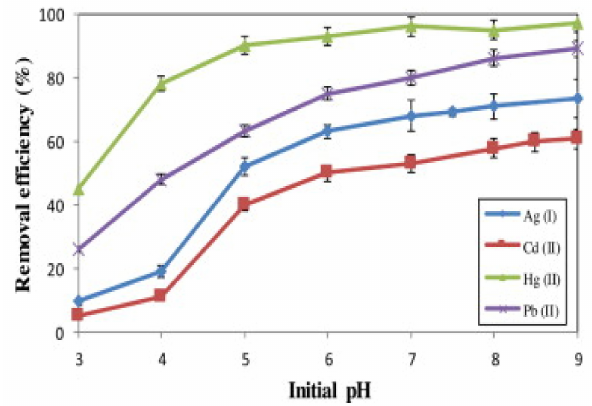
Figure 7. Removal efficiency with varying pH (polymer encapsulated maghemite). Reproduced with permission from